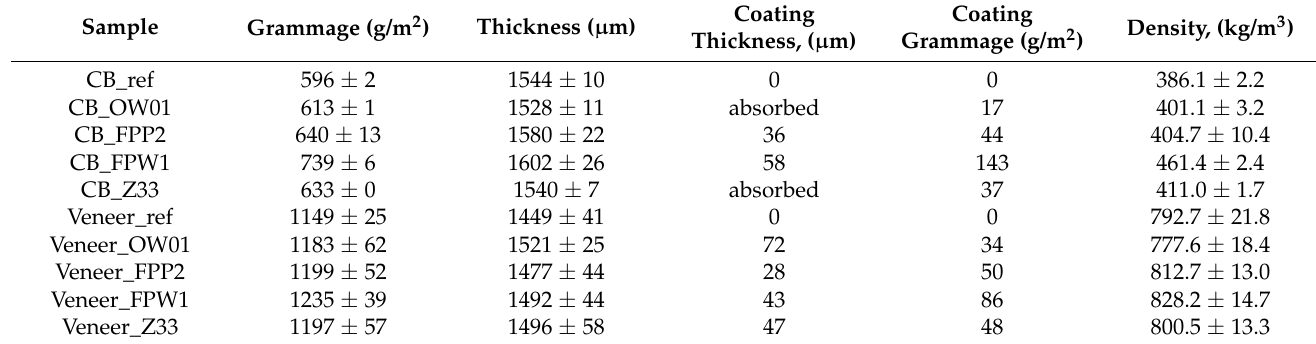
Table 1. Thickness, weight and density of uncoated and fire-retardant-coated cardboard (CB) and veneer